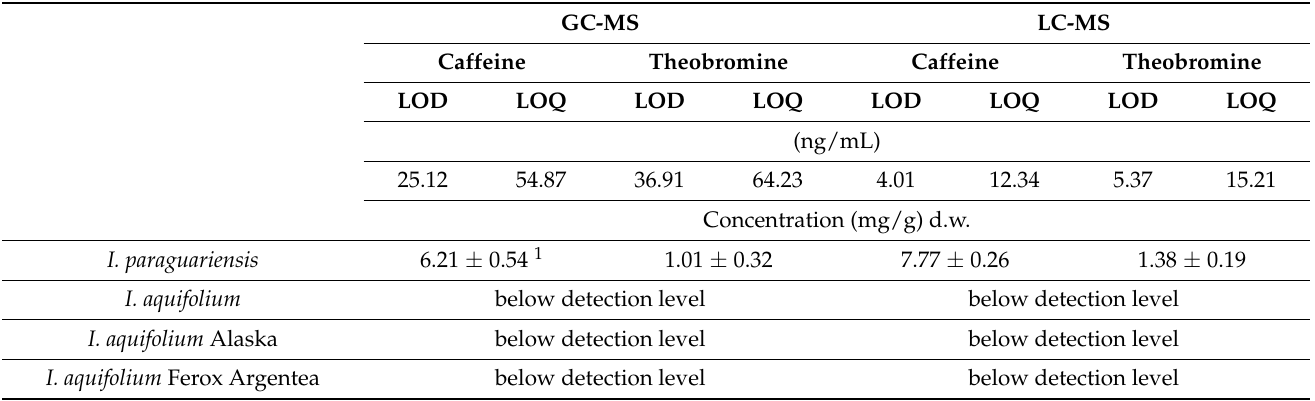
Table 6. Comparison of the quantity of caffeine and theobromine isolated from I. paraguariensis and various I. aquifolium cultivars analyzed by means of GC-MS and LC-MS. GC-MS